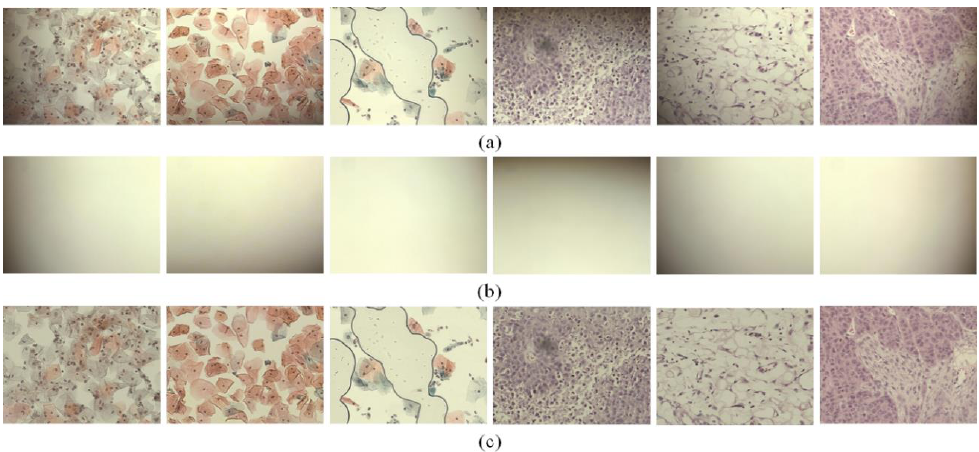
Figure 4. Examples of image tiles with shading corrected by the proposed method: ( a ) input image tiles, ( b ) flat-field distortion models and ( c ) shading-corrected images.